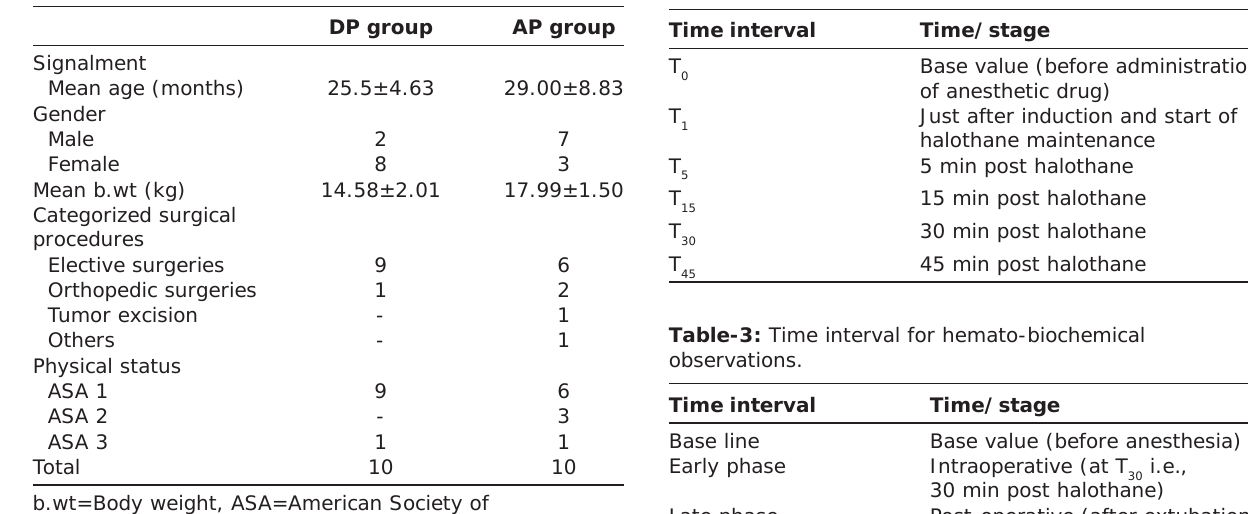
Table-1: Patient classification. Table-2: Time interval for recording various observations.